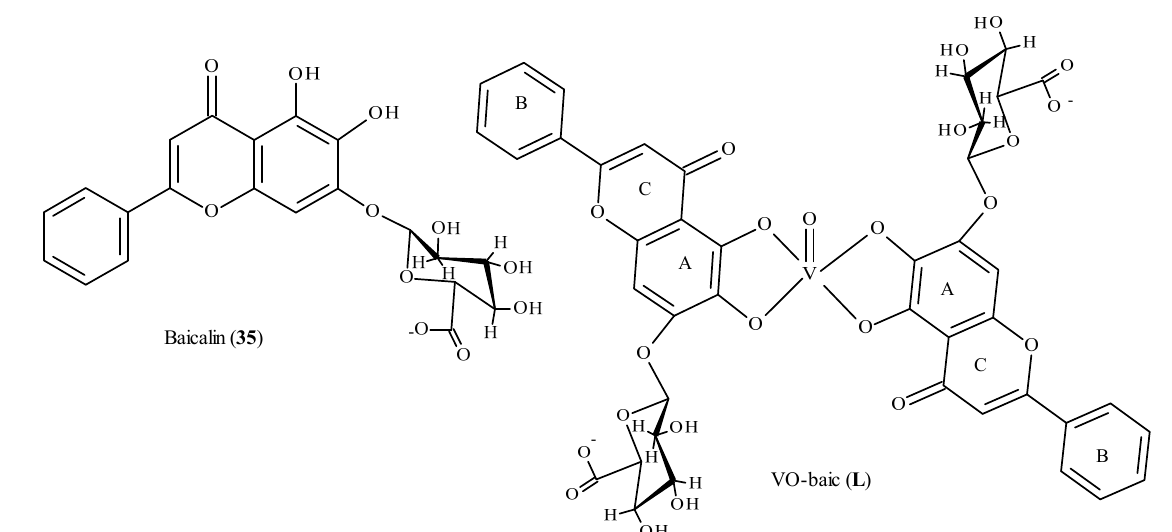
Figure 7. Structures of baicalin ( 35 ) and its vanadium(V) complex VO(baic) ( L ). Complexes of quercetin ( 3 ) and naringerin ( 30 ) with nickel(II) and copper(II) (Scheme 2) were compared in terms of their antioxidant capacities and phenolic contents. The phenolic contents of these complexes were, respectively 0.17 ± 0.01; 0.21 ± 0.01; 0.67 ± 0.04 mg